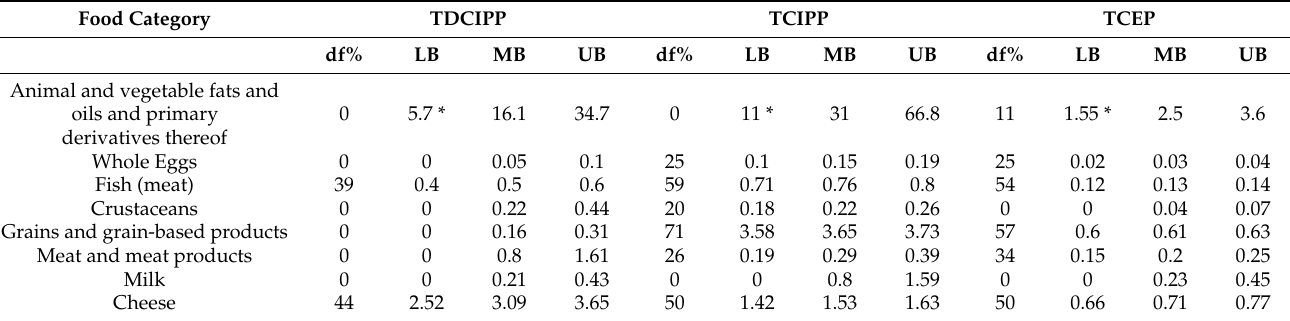
Table 1. Occurrence data of TDCIPP, TCIPP and TCEP concentration in the analysed food categories in µ g/kg provided by Poma et al.